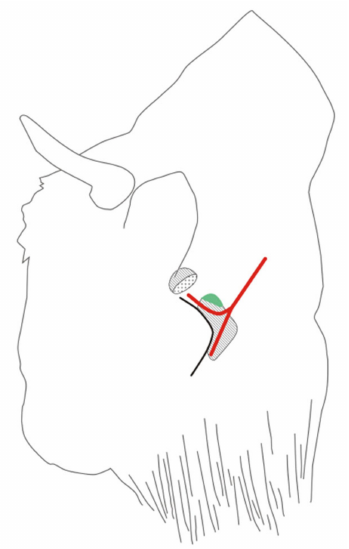
Figure 1. The location of the biopsy needle insertion in the European bison, performed to collect a fragment of the retropharyngeal lateral lymph node. Legend: hatched organs: above the projection of the parotid gland, below the projection of the mandibular gland. The projection of the lateral retropharyngeal lymph node is given in green. Red lines: upper—projection of the maxillary vein, lower—projection of the lingual–facial vein. The maxillary vein and facial–linguistic vein converge into the external jugular vein.